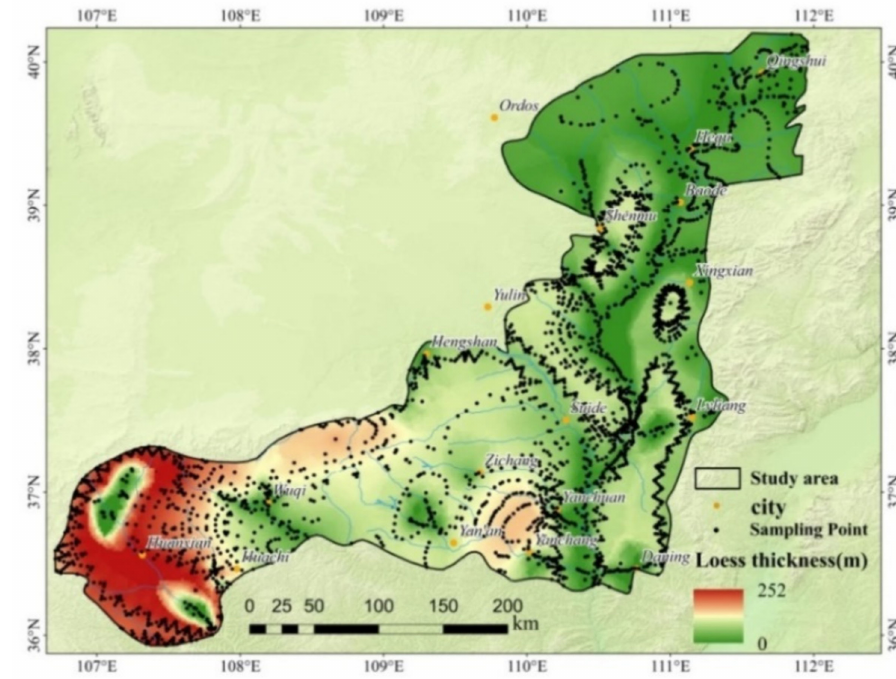
Figure 3. The distribution of sampling points and loess thickness map of the study area.